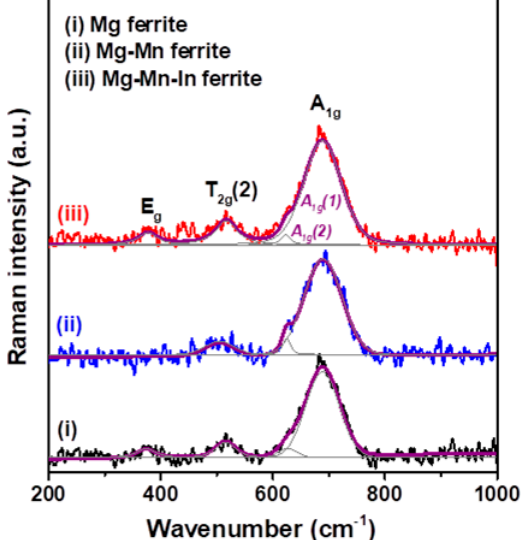
Figure 2. Raman spectra as a function of wavenumber for as-prepared Mg, Mg-Mn, and Mg-Mn-In